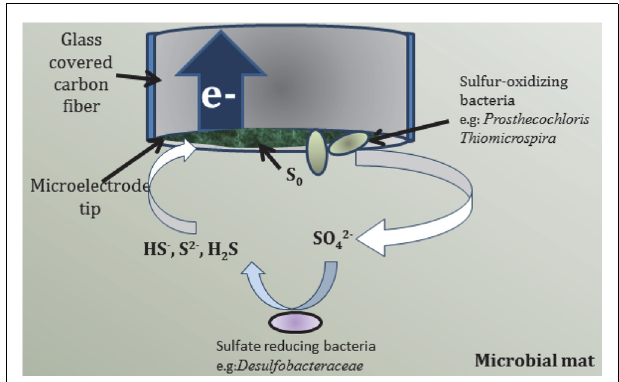
FIGURE 8 | Proposed pathway of bioelectrochemical cycling of sulfur species at the microelectrode